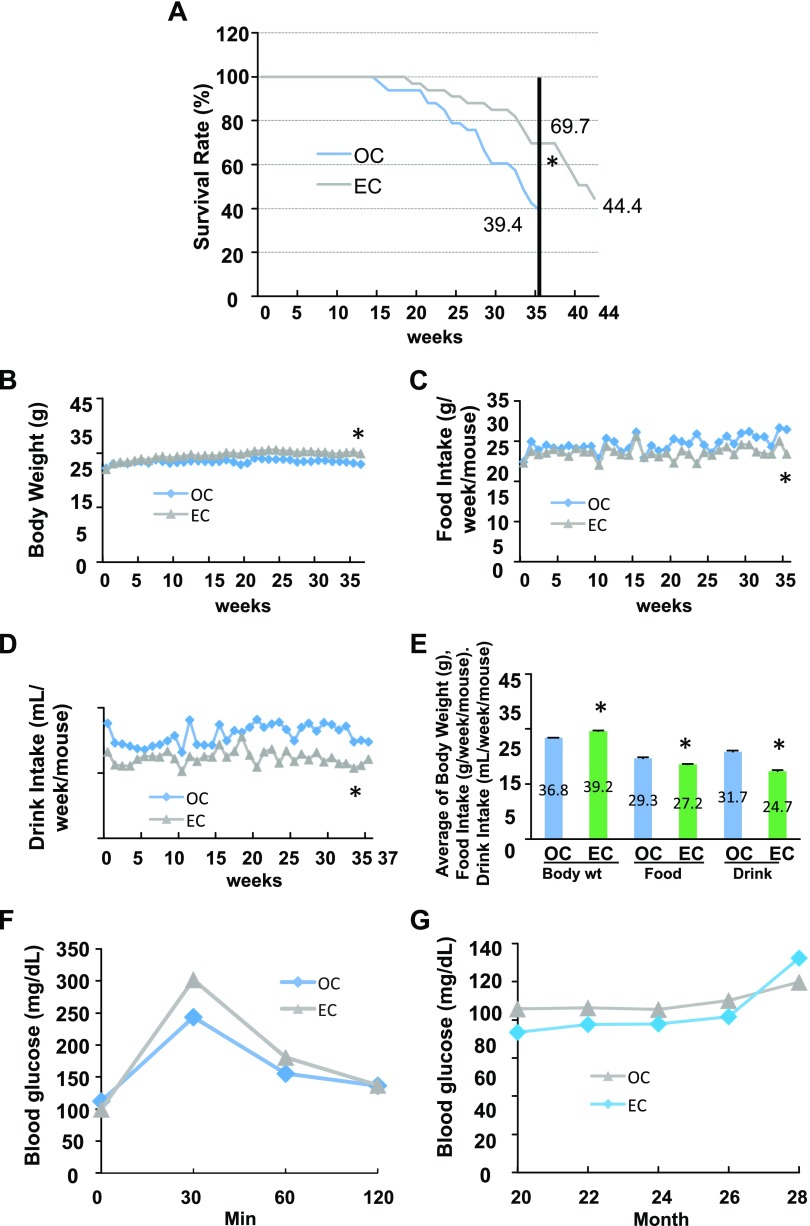
Effects of dietary supplementation of epicatechin on survival rate in aged mice fed a standard diet. Twenty-month-old male C57BL/6 mice were treated with EC (0.25% w/v in drinking water) or control (OC) for 37 or 44 wk (n = 33/group). A) Epicatechin intake significantly increased survival rate of mice. B–D) Epicatechin intake enhanced BW (B) while decreasing food and drink intake (C, D) during the experimental period. E) The average BW, food intake, and drink intake of the entire experimental period. F, G) Epicatechin intake did not significantly affect the results of the glucose tolerance test (F) or fasting plasma glucose levels (G). *P < 0.05 EC vs. OC (n = 12–33).